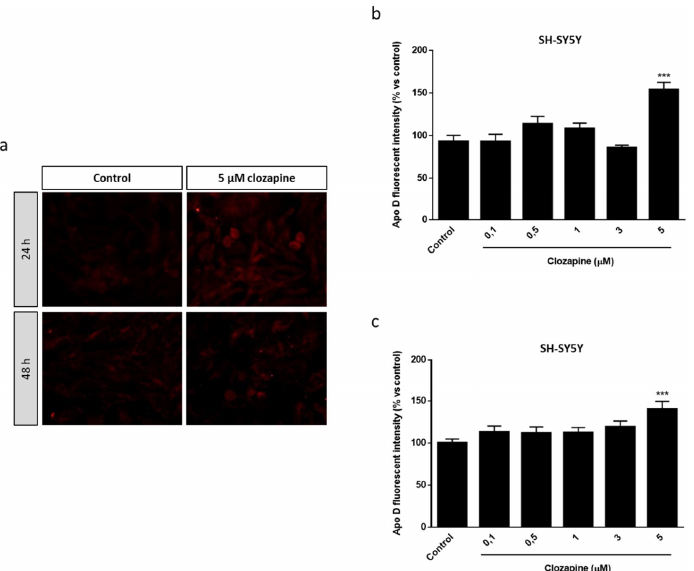
Figure 6. Representative fluorescence microscopy images of Apo D expression in SH-SY5Y cells treated or not with 5 µM of CLO during 24 and 48 h. 40× magnification ( a ). Densitometric quantification of Apo D immunocytochemical signal after 24 ( b ) and 48 h ( c ) of treatment with increasing concentrations of CLO (0.1–5 µM) in SH-SY5Y cells ( n = 6). Bars represent mean density per cell ± SEM (% versus control) in a 40× field. Significant differences were analyzed by a one-way ANOVA followed by post-hoc Tukey’s test. *** p < 0.001 compared with control.